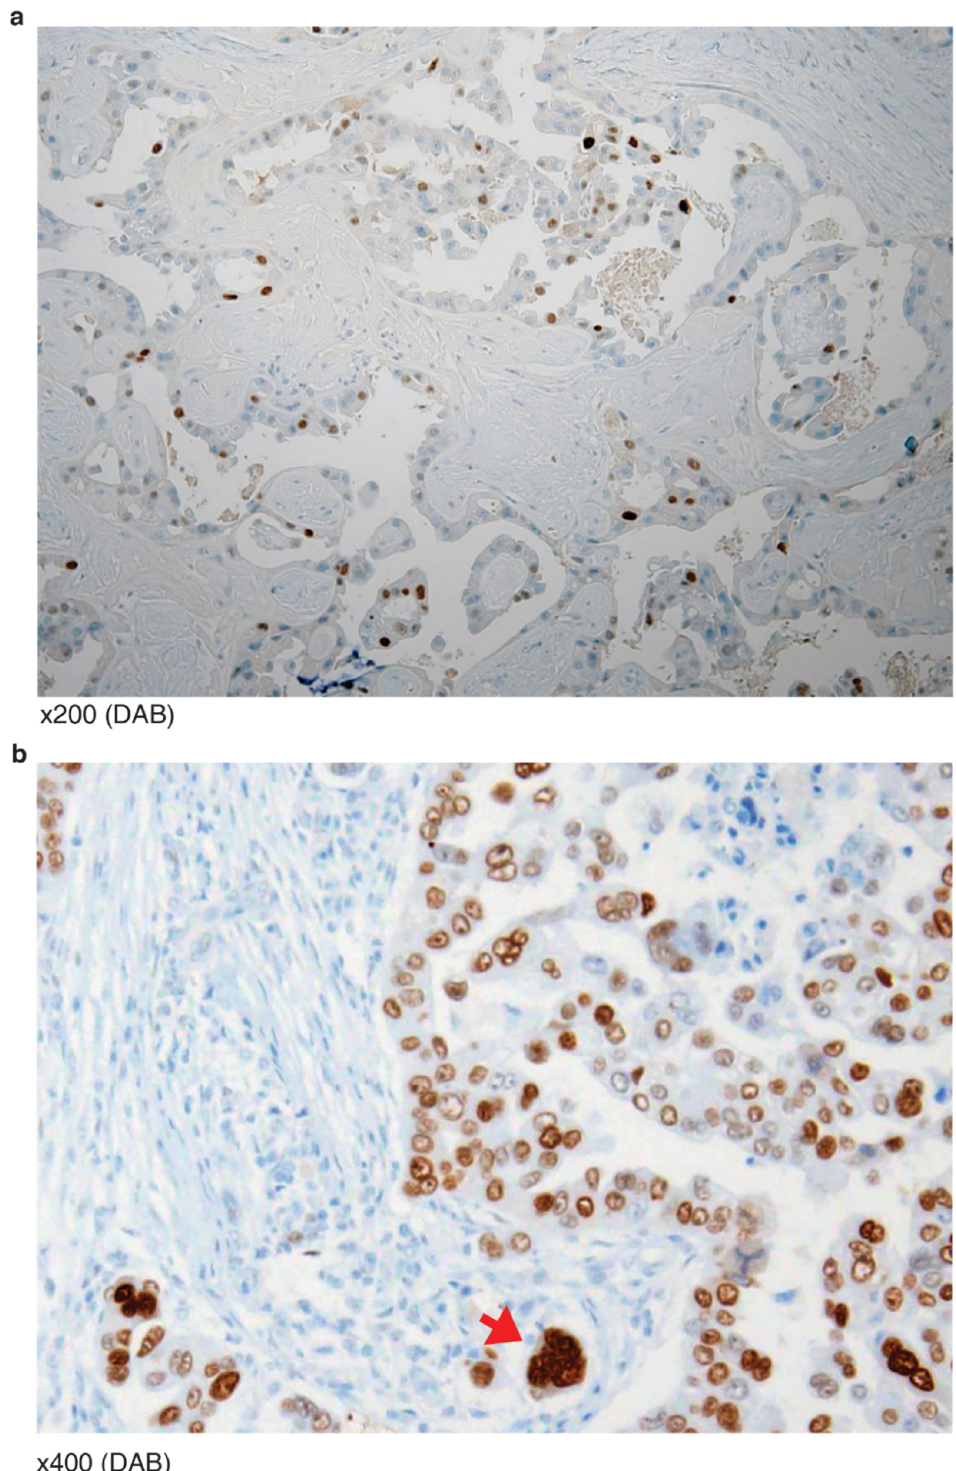
Figure 6. IHC mosaic patterns of p53 from two tumors of TP53 NLS mutation (P301Qfs*44(del): ( a ) Well-differentiated serous carcinoma with intermittent partly positive signals. ( b ) Scattered positive cells with relatively high intensity are bizarre multinucleated cells (red arrow) undergoing aneuploidy.